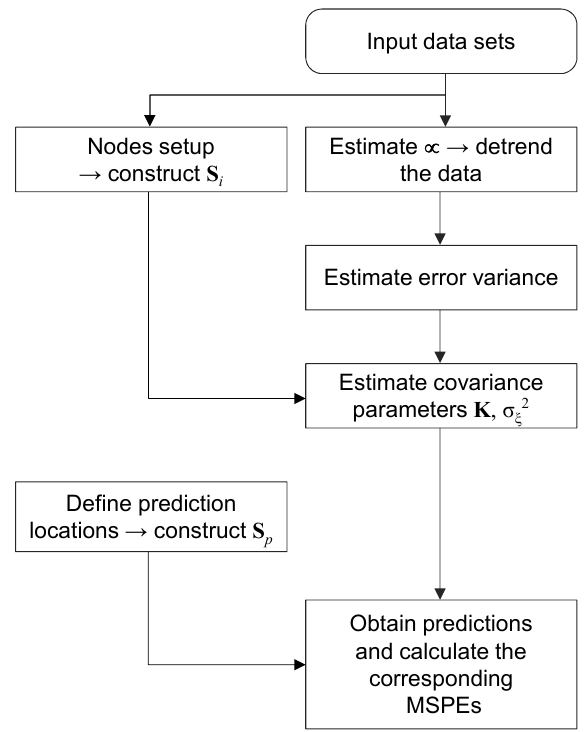
Figure 7. Obtaining predictions via the FRK method.